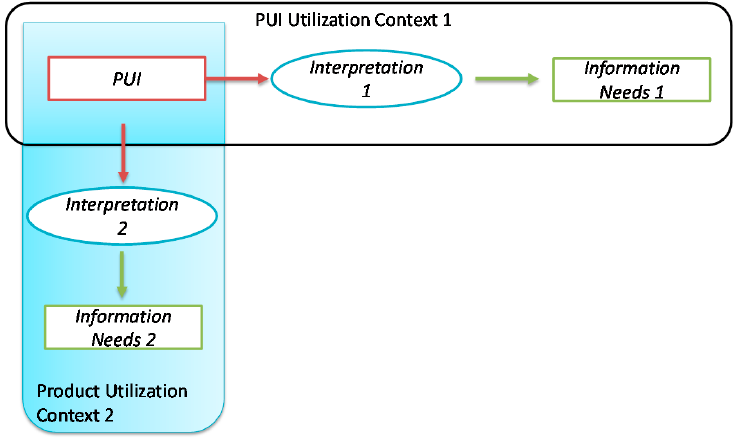
Figure 5. Interpretation of PUI for information needs in different contexts.